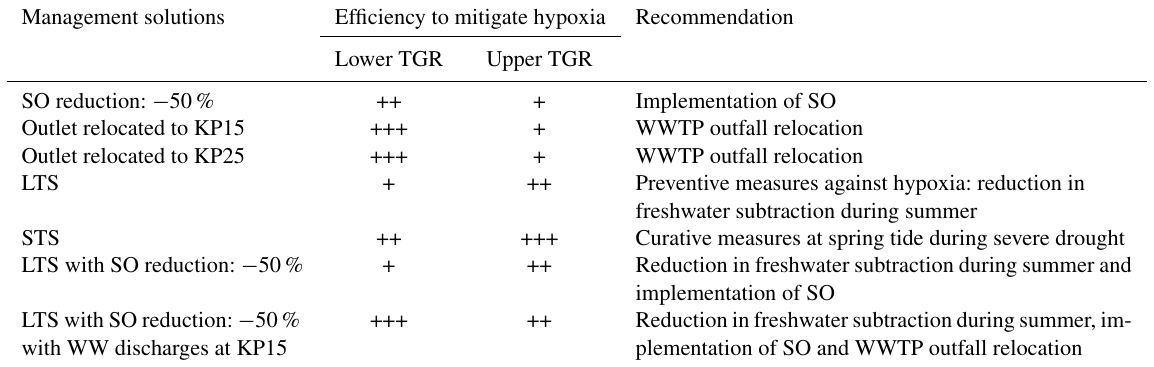
Table 4. Summary of management solution efficiency and recommendations (WW: wastewater; WS: watershed). The level of efficiency of each solution is detailed for the lower and upper TGR according to the scale: low (+), moderate (++) and high (+++).